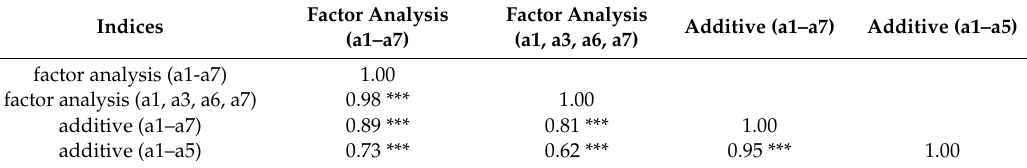
Table A4. Correlation between di ff erent privacy concern specifications.